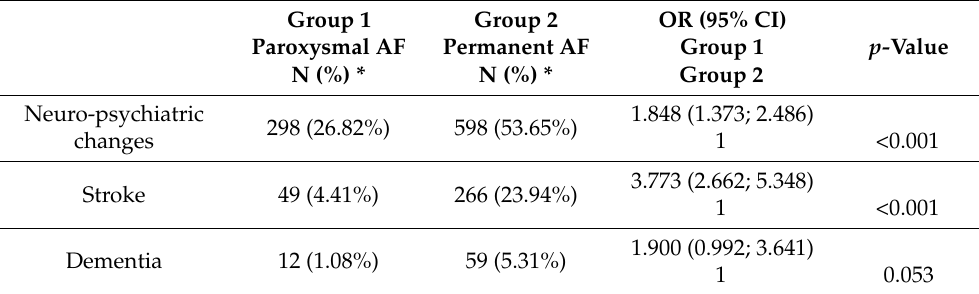
Table 5. Logistic regression analysis for occurrence risk of neuropsychiatric changes, stroke, dementia, after AF diagnosis.